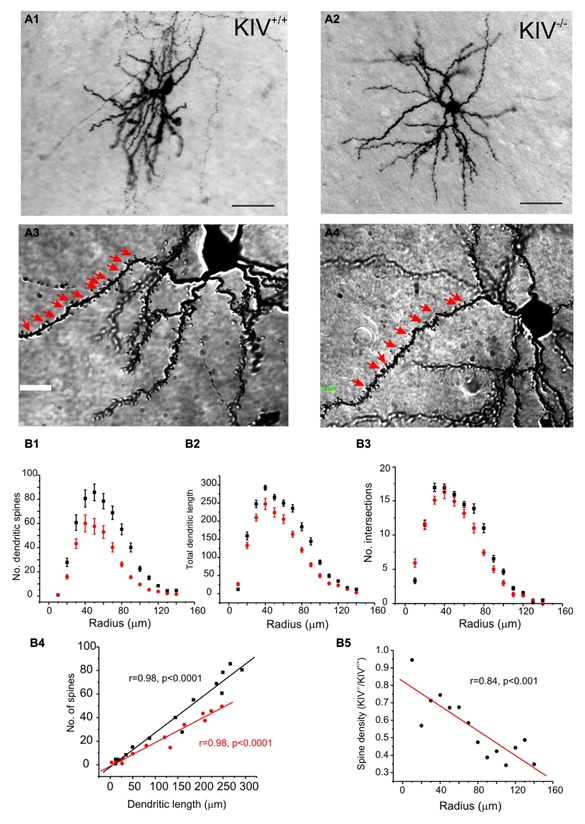
Altered dendritic morphology in KIV–/– mice. (A) Photomicrograph of a pair of neurobiotin labeled spiny stellate cells from littermate wild-type (A1,A3) and KIV-/- mice (A2,A4), respectively. Scale bar in (A1,A2) 10 μm; Scale bar in (A3,A4) 2 μm. White arrows in (A3,A4) dendritic spines. (B) Sholl analysis was performed to compare the distribution of dendritic spines (B1), the distribution of total dendritic length (B2), as well as the no. of intersections (B3) along different dendritic radiums from the soma. (B4) The average no. of dendritic spines was plotted against its dendritic length in wild-type mice (black squares) and KIV-/- mice (red circles). (B5) the spine density in wild-type vs. KIV-/- mice was plotted against the dendritic radius from the soma. n= 25 and 19 wild-type and mutant spiny stellate cells, respectively.